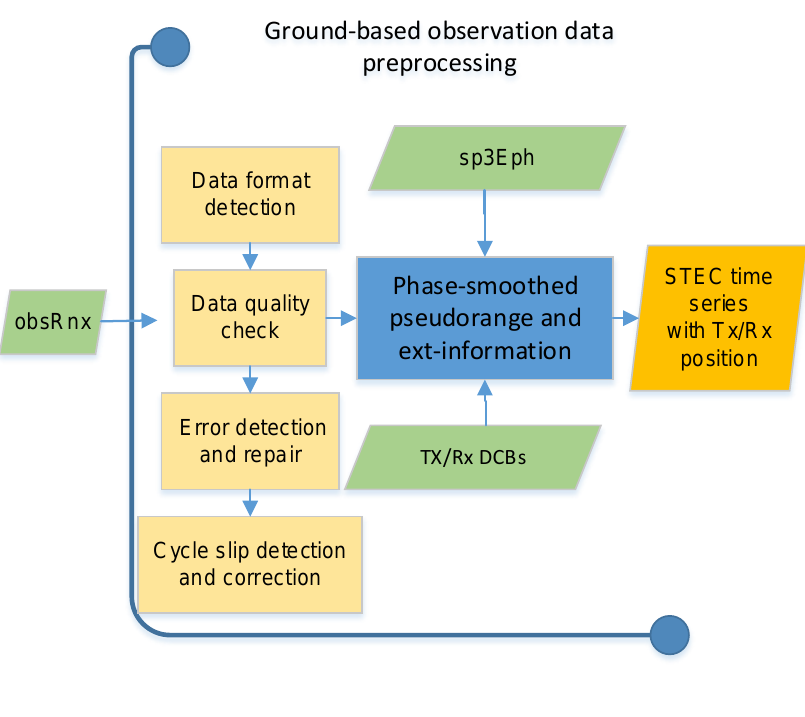
Figure 3. Ground-based data processing